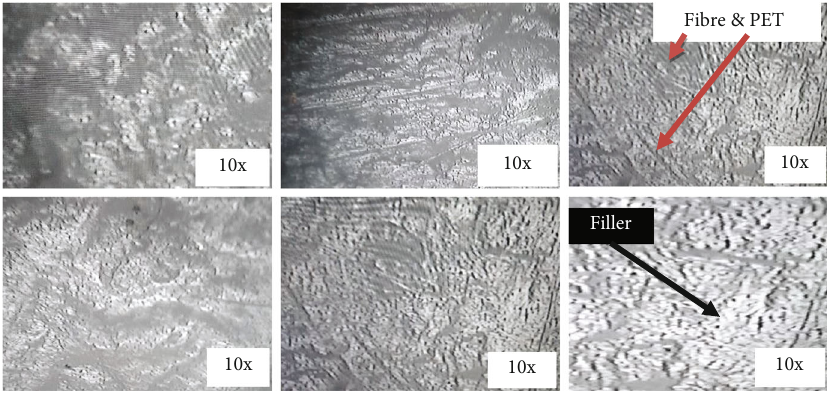
Figure 16: Microstructure of di ff erent